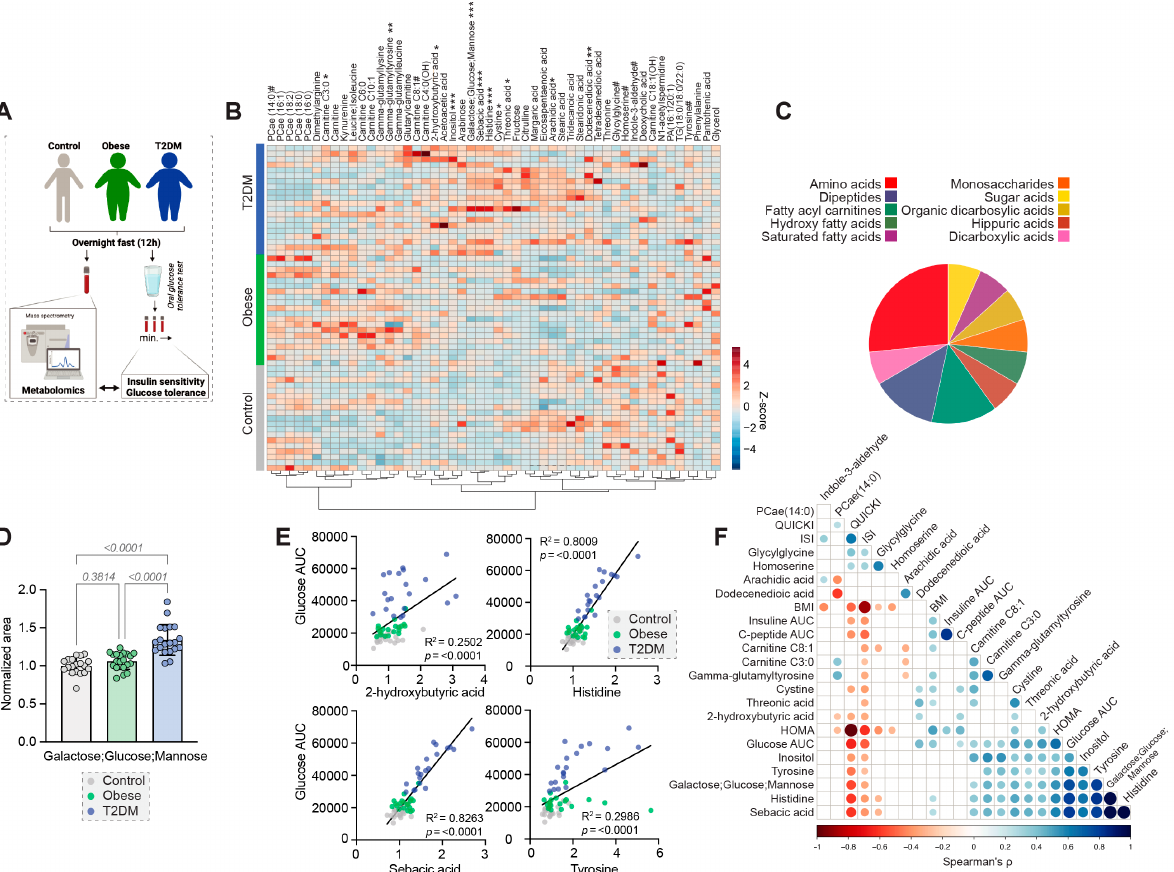
Figure 2. Differences in the 12h metabolomes. ( A ) Schematic overview of the analysis approach. (( A ) was created with BioRender.com) ( B ) Heatmap of the 50 top ANOVA-ranked metabolites. FDR- corrected p -values # < 0.1, * < 0.05, ** < 0.01, *** < 0.001. ( C ) Classification of significantly different metabolites. ( D ) Differences in the levels of Galactose; Glucose; Mannose, normalized to the mean of the non-obese cohort. ( E ) Simple linear regression analyses of selected metabolites and the glucose AUC during OGTT. ( F ) Spearman correlation matrix between significantly different metabolites and glycaemic parameters. The color and size of the dots correspond to the correlation coefficient. p -value cut-off